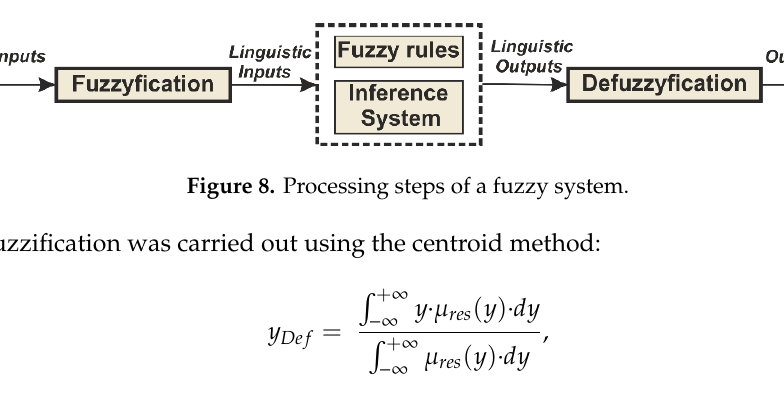
Figure 9. Architecture of the fuzzy logic system applied to develop the strain-based method.